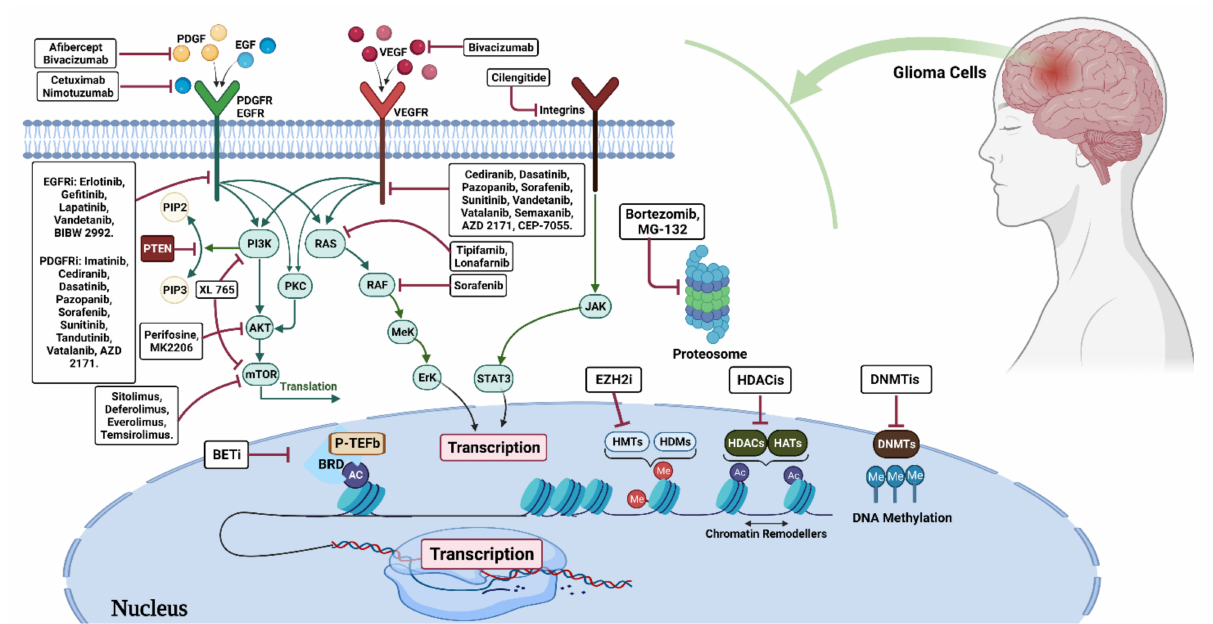
Figure 1. Schematic overview of molecules that have a vital role in GBM treatment. Growth factor receptors and intracellular signaling pathways can be activated in glioblastoma, thereby triggering gliomagenesis. Such pathways have the ability to induce tumor survival, invasiveness, proliferation, evading apoptosis, and avoiding immune surveillance [69]. EGF, VEGF, and PDGF, as well as the receptors thereof, can be blocked by small molecules and monoclonal antibodies [69]. Epigenetic process inhibitors, such as HDACis, DNMTis, BETis, and EZH2is, also have an important role to play in the treatment of patients suffering from GBM